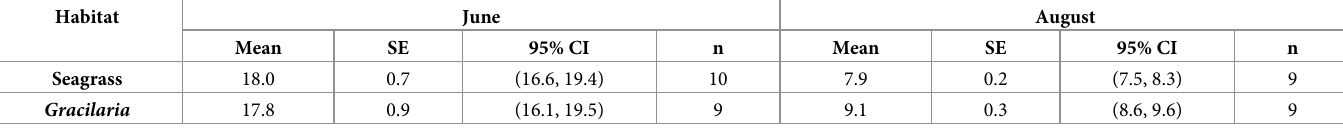
experiencing periodic mass mortality events due to above average summer water temperatures combined with other environmental stressors like increased turbidity [82]. Thus, Gracilaria may increasingly impact seagrasses due to their interaction. For instance, Gracilaria tends to exacerbate the negative effects of elevated temperature regimes (26–30˚C) on Z. marina , which experiences decreased growth and increased mortality [83, 84]. In contrast, growth of Graci- laria is positive over a range of temperatures (5–30˚C) with maximum growth from 15–25˚C [73, 74, 77]; decreased growth and increased mortality only occur at temperatures exceeding 32.5˚C [74, 77].